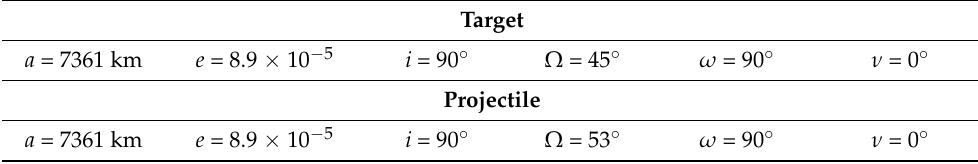
Table 5. Orbit parameters of parents.